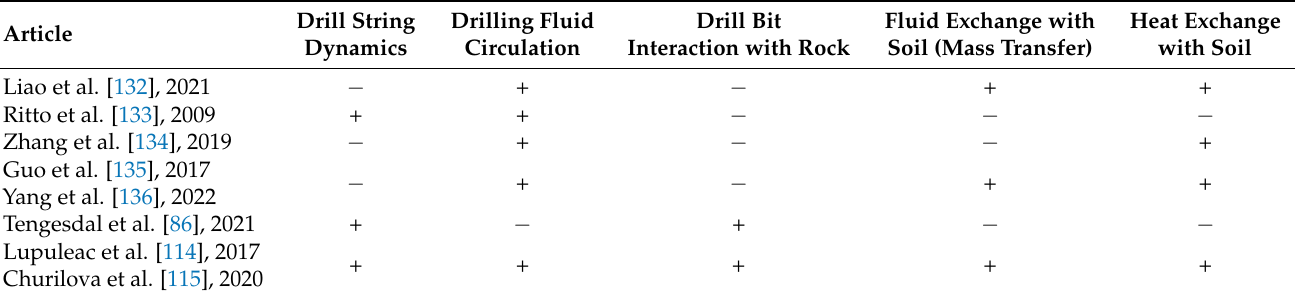
Table 1. Complex modeling of well drilling